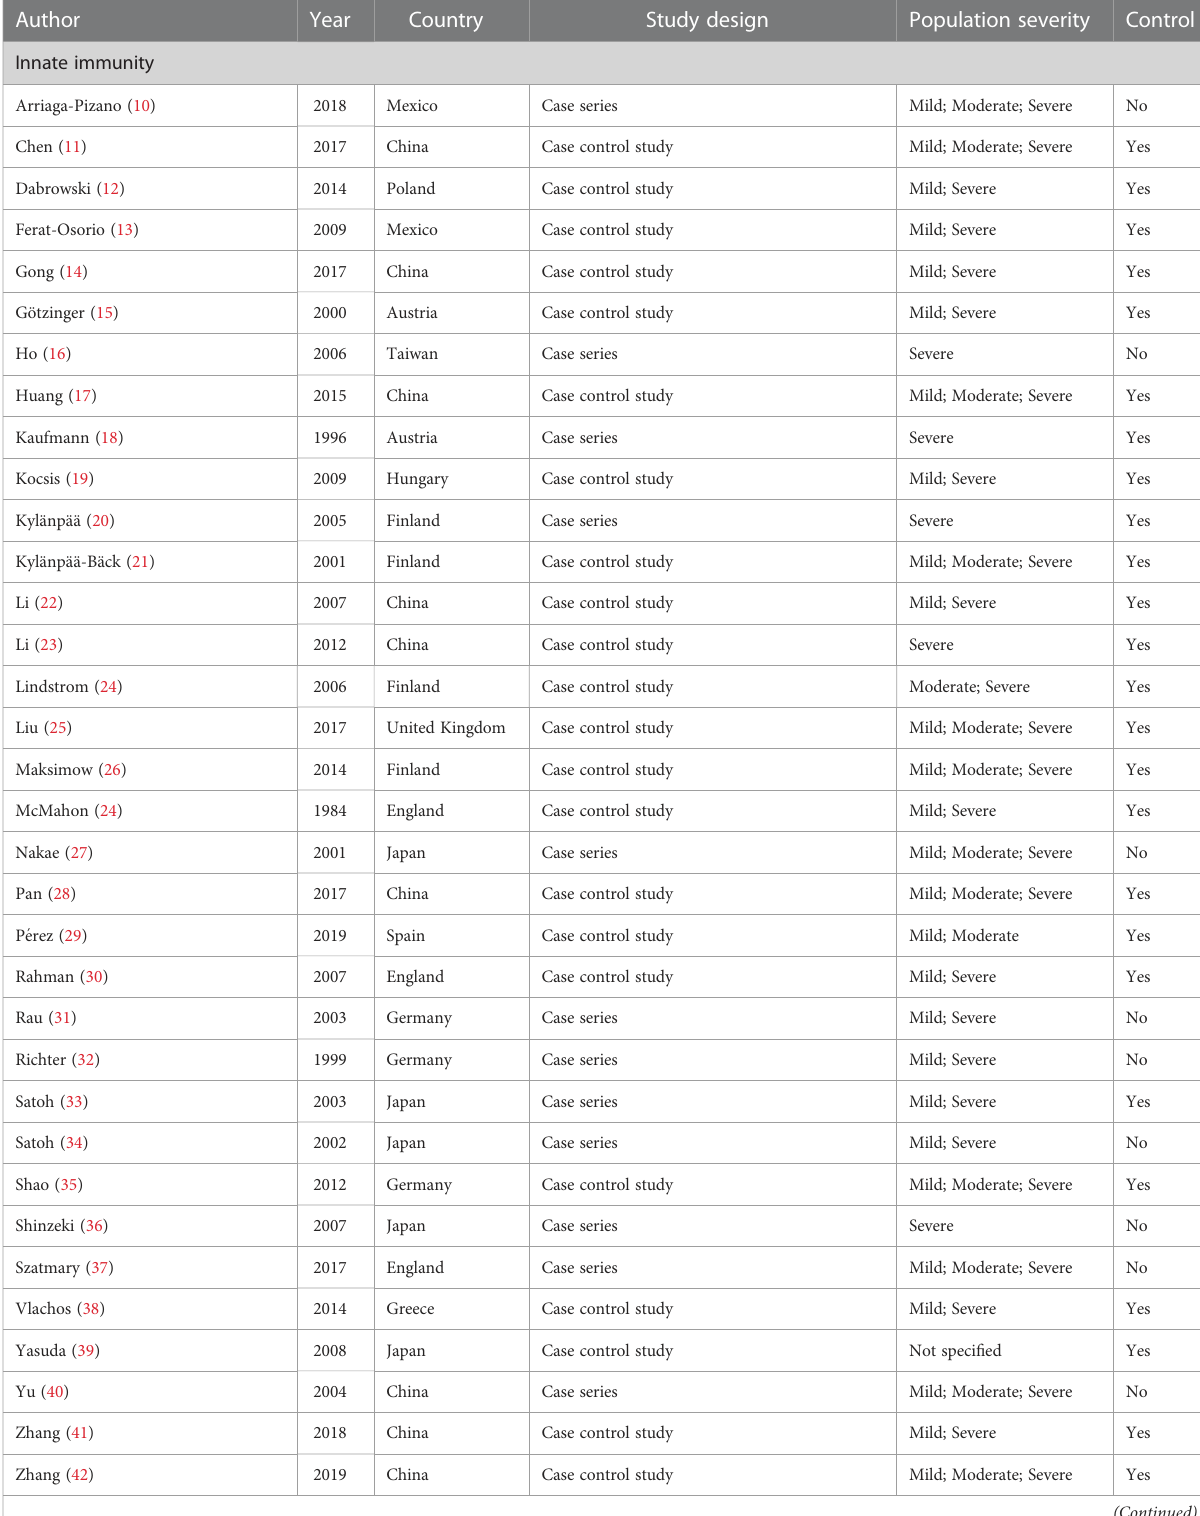
TABLE 2 All studies identi fi ed in initial search by primary focus area - innate immunity, cytokines, genetics, leukocyte-mediated, cytokine, gut permeability, or